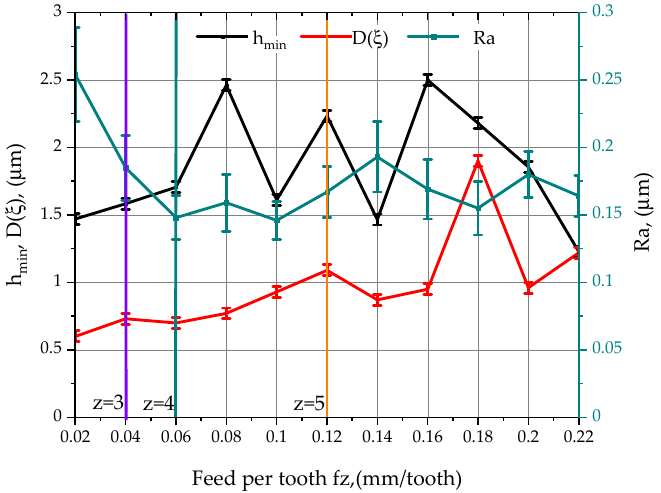
Figure 8. Effect of f z feed rate changing and selected machining conditions on the Ra parameter of the surface roughness of aluminium alloy 2017A.